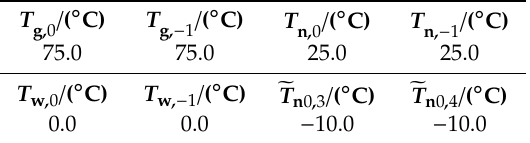
Table A7. Initial operation values of heating / cooling